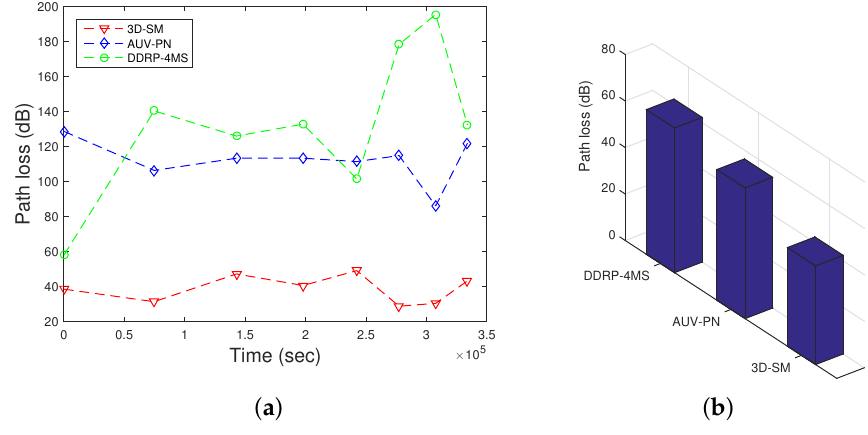
Figure 11. Path loss. ( a ) when all nodes die; ( b ) when first node